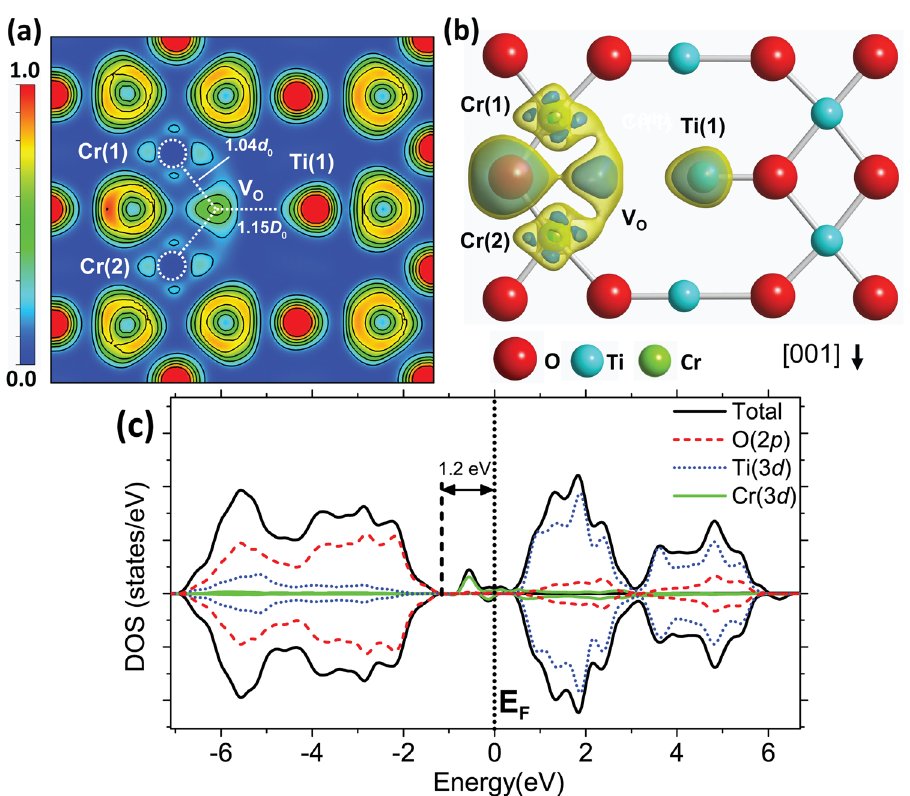
Figure 5. ( a ) ELF cross section along the (110) plane with a combined 2Cr Ti0 + V O0 defect. Dotted circles and lines represent the Cr atoms and dangling bonds, respectively. ( b ) ELF isosurfaces for an ELF value of 0.11 (yellow/light) and 0.21 (blue/dark) around the nearest Cr, Ti and O atoms from the V O defect. ( c ) Spin polarized ( s + , s − ) total DOS and pDOS corresponding to O(2 p ), Ti(3 d ) and Cr(3 d ) states for the combined 2Cr Ti0 + V O0